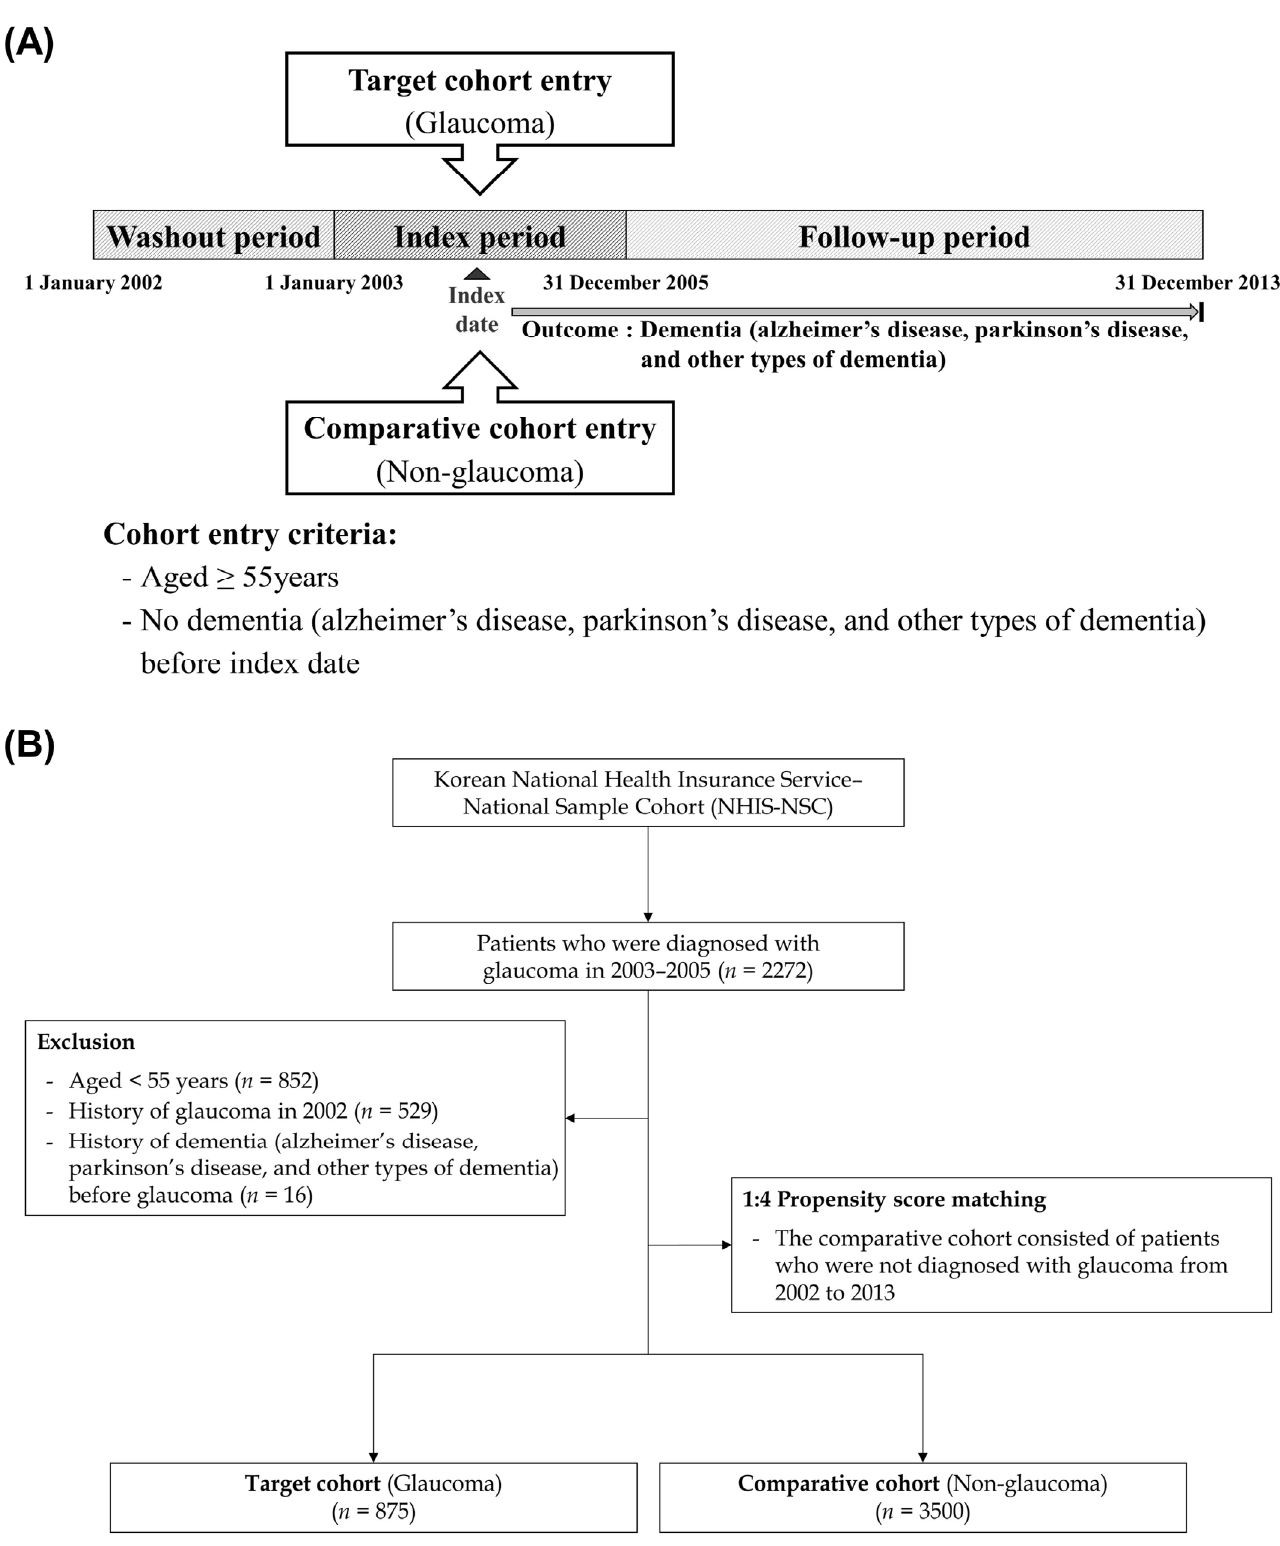
Figure 1. ( A ) Schematic study design; ( B ) process of study enrolment.